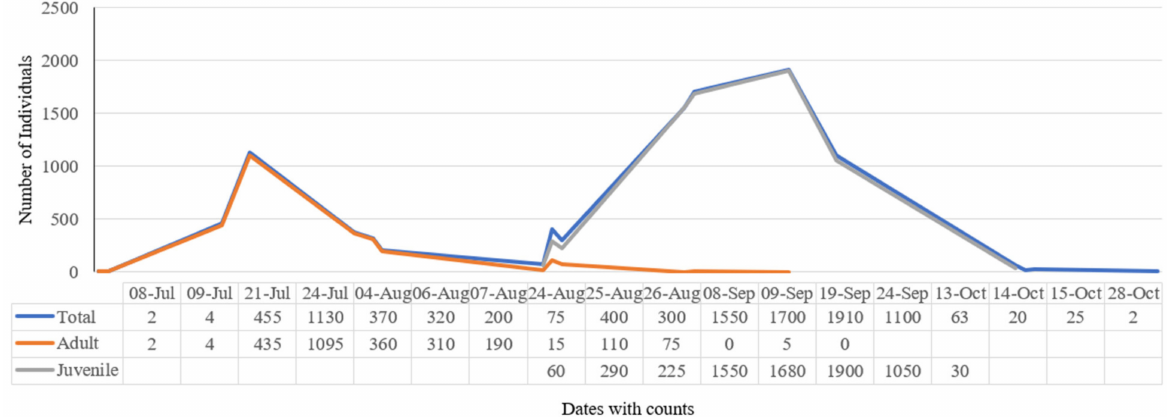
Figure 5. Changes in the number of adult-plumaged and juvenile Calidris ruficollis in the Hwaseong Wetlands FNS revealed by 18 dates of counts made during the southward migration period,